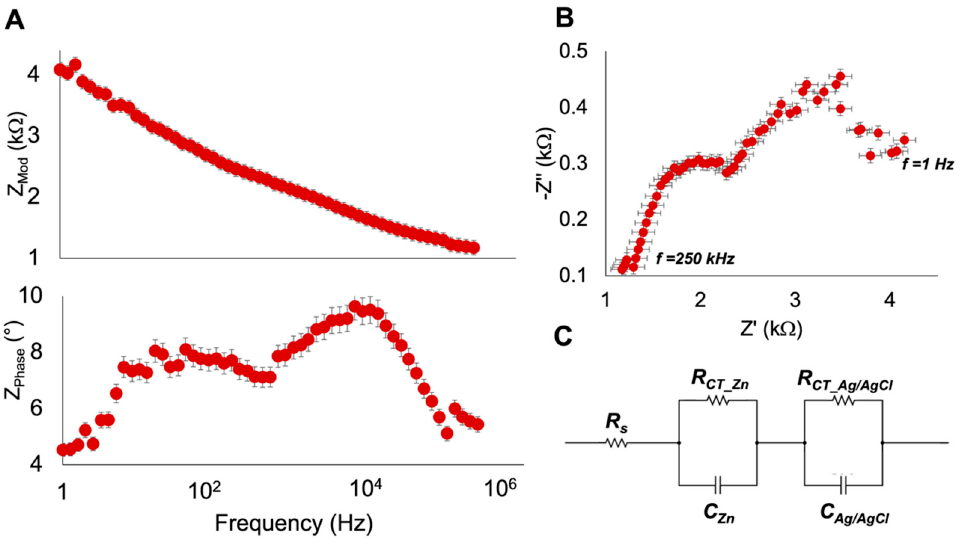
Figure 4. EIS for the screen-printed battery ( A ) The Bode plot that shows impedance modulus and phase as a function of the probing frequency (1 Hz–250 kHz). ( B ) The Nyquist plot for the cell over the same frequency range, and ( C ) The equivalent circuit used for a fit to generate values in Table 1 for the cell. Table 1. Equivalent Circuit Values for a Single Cell